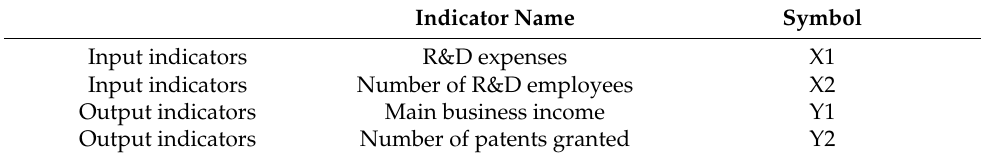
Table 2. Input–output indicators of the TI of carbon capture technology enterprises.